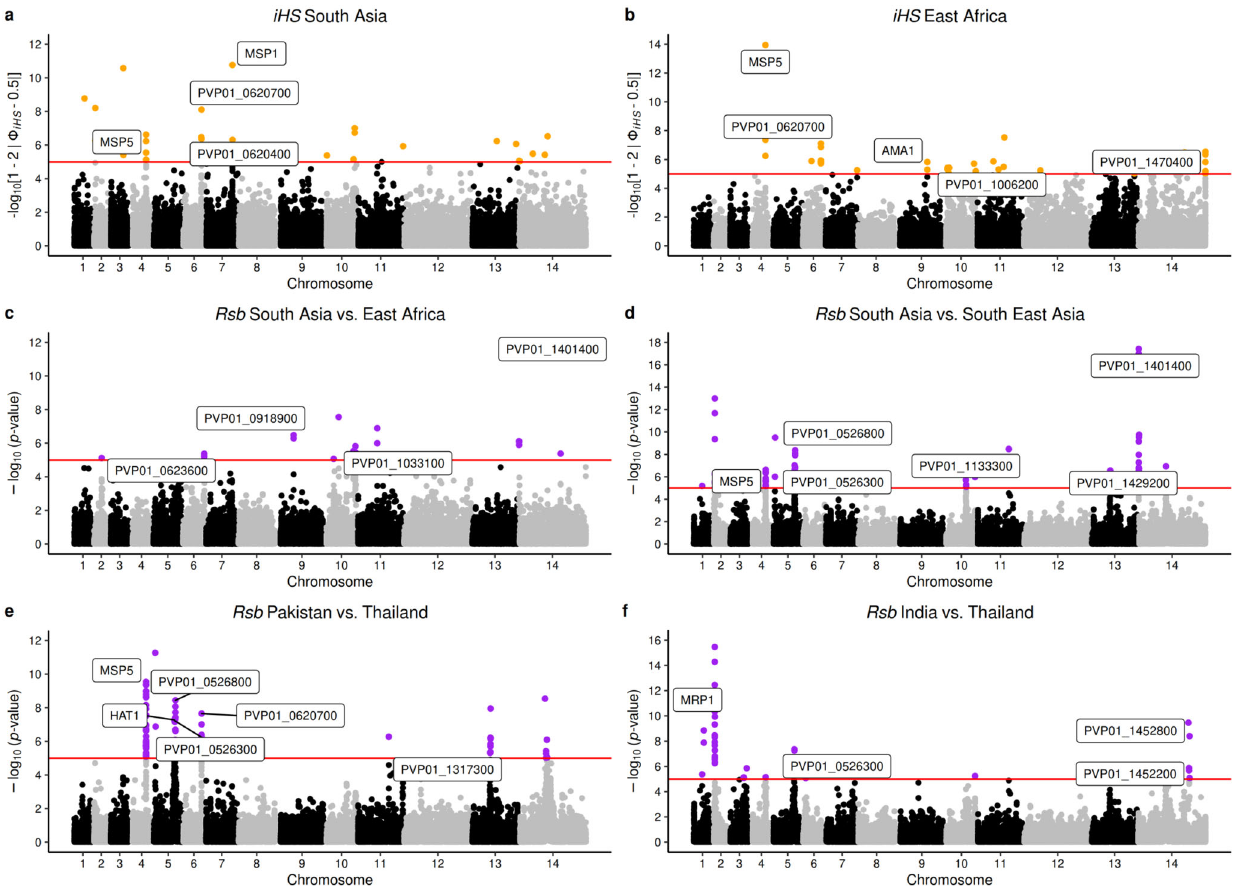
Fig. 2 Evidence of selective sweeps. Manhattan plots showing the genome-wide results of the iHS analysis on P. vivax from South Asia and East Africa regions ( a, b ); Rsb analysis for P. vivax between geographical regions ( c , d ) and countries ( e , f ). Loci in critical regions (above red lines: orange points iHS P < 1 × 10 − 5 ; purple points Rsb P < 1 × 10 − 5 ; two-sided tests) are reported in Supplementary Data 6 and Supplementary Data